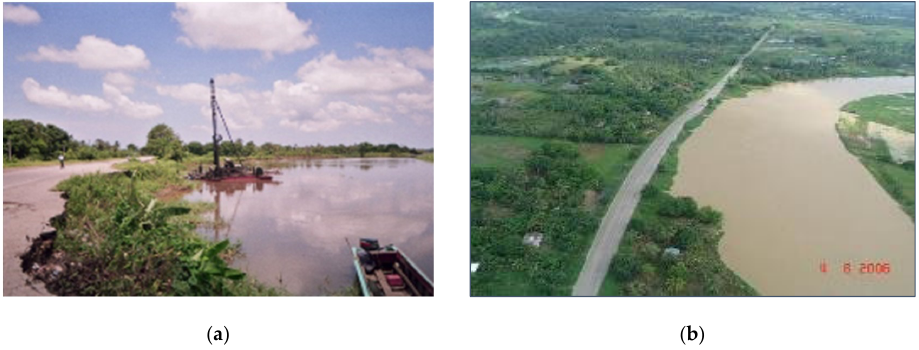
Figure 10. Sinú River, Trementino: ( a ) at the beginning of the panel installation in September 2003; ( b ) condition in August 2006, three years later (Hidroconsulta, 2003; 2006).